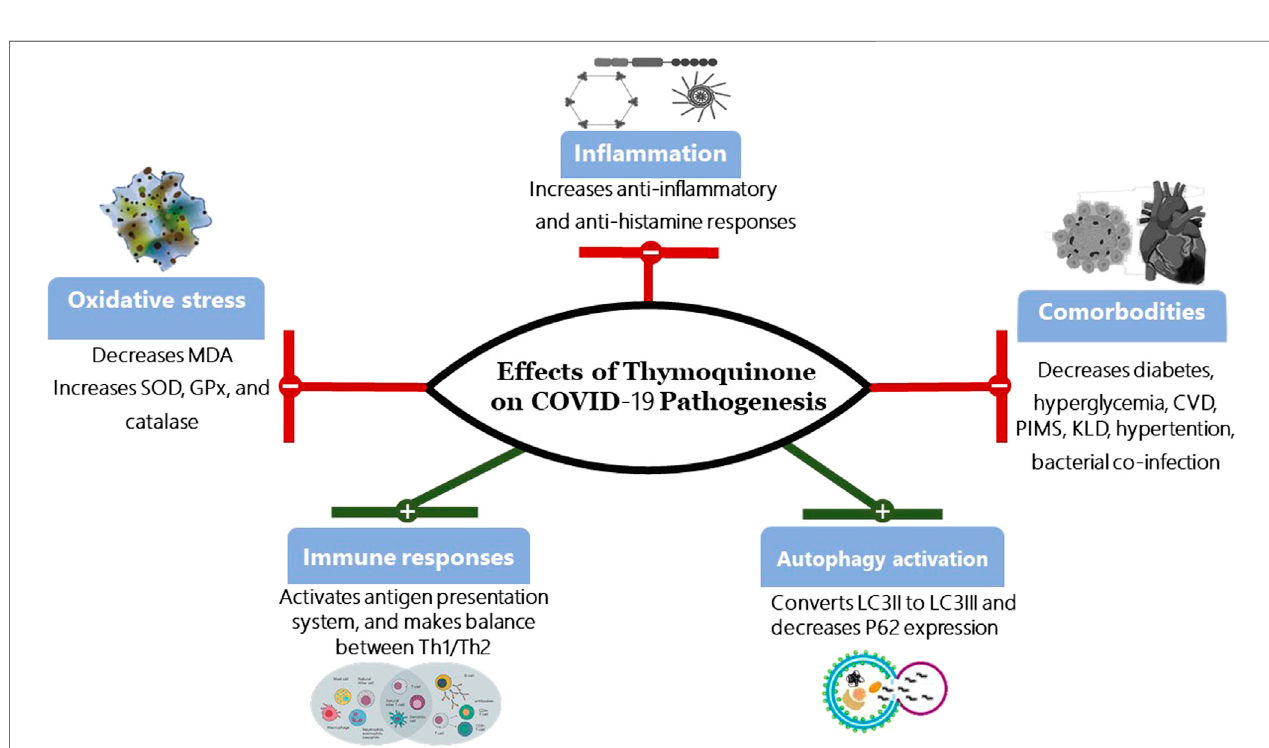
FIGURE 2 | Effects of Thymoquinone on COVID-19 Pathogenesis. SOD, Superoxide dismutase; GPx, Glutathione peroxidase; MDA, Malonaldehyde Th1, type I helper T lymphocytes; Th2, type II helper T cells; CVD, Cardiovascular disease; PIMS, Paediatric In fl ammatory Multisystem Syndrome; KLD, Kawasaki-like diseases; LC3, Microtubule-associated protein 1A/1B-light chain 3; P62, protein 62.